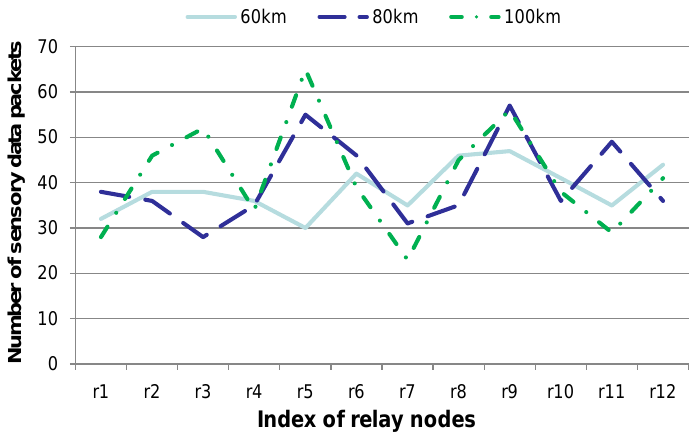
Figure 8. Comparison of the number of sensory data packets when sensor nodes are deployed in diverse skewness distributions in the network region. This figure shows that different sensor node deployment strategies may have a relatively large impact on the number of sensory data packets to be forwarded by certain relay